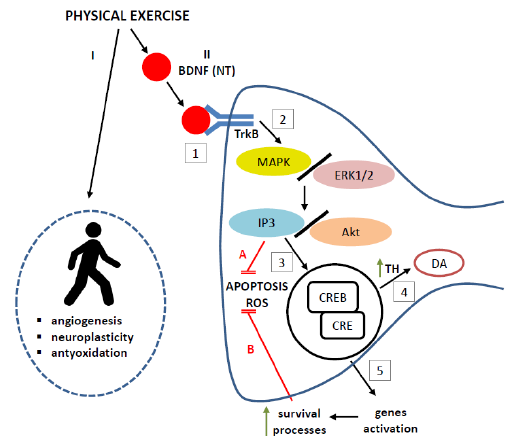
Figure 4. Systemic (I) and central nervous system (II) responses to physical exercise. (I) Physical exercise promotes angiogenesis and neuroplasticity, and anti-oxidation counteracts oxidative stress. (II) Physical exercise increases BDNF affinity to the TrkB receptor (1) enhancing a cascade of intracellular